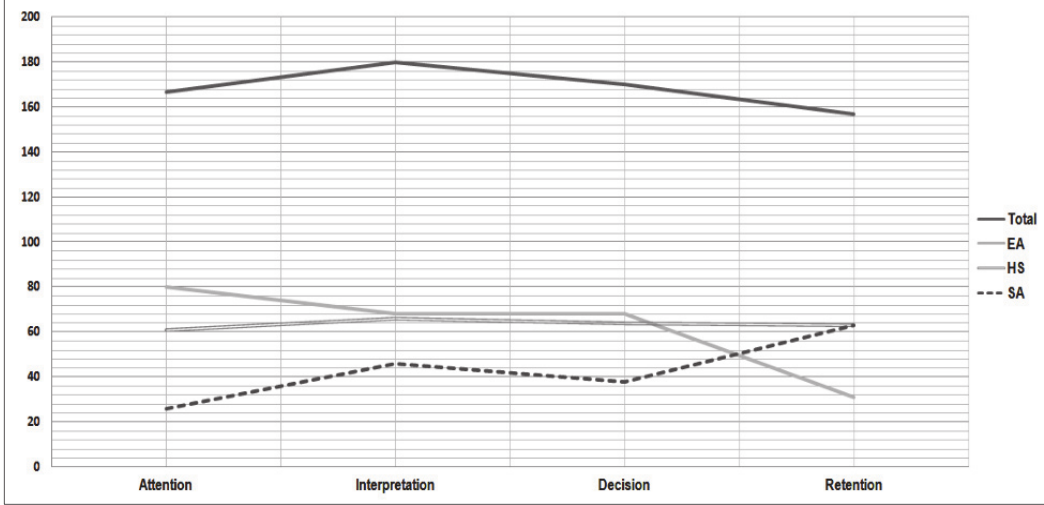
<Figure 8> Distribution of Publications on Consumer